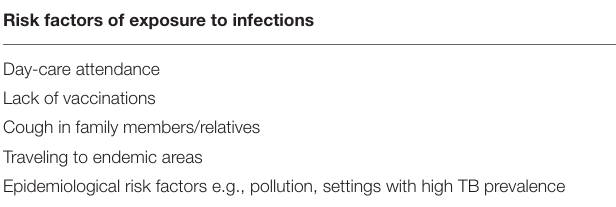
TABLE 13 | Questioning about risks of exposure to infections. Risk factors of exposure to infections Day-care attendance Lack of